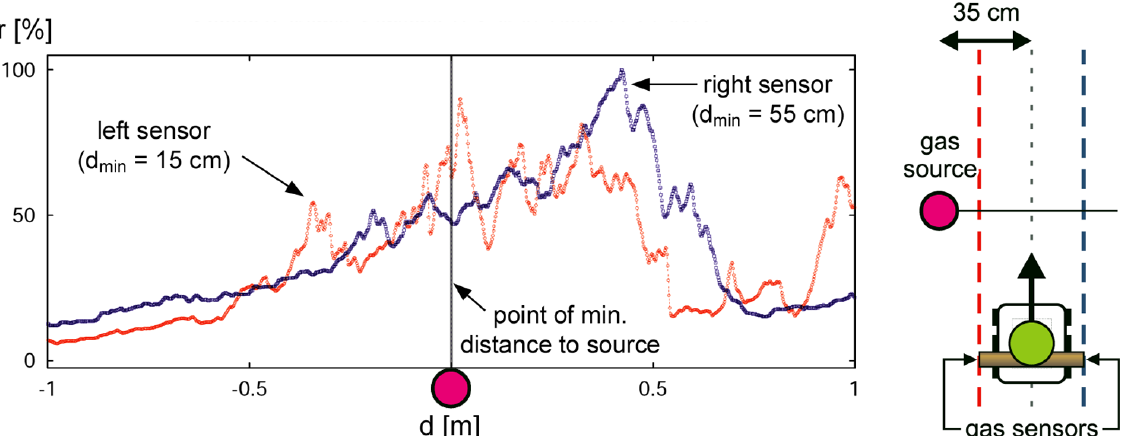
Figure 3 . Example of gas sensor readings recorded while the robot passed a source of evaporating ethanol along a straight line (as shown on the right side) at a low speed of 0.25 cm/s. The curve dis- plays relative conductance values of two metal oxide sensors (hence higher values correspond to higher concentrations), which were mounted on the left and right side of the robot with a separation of 40